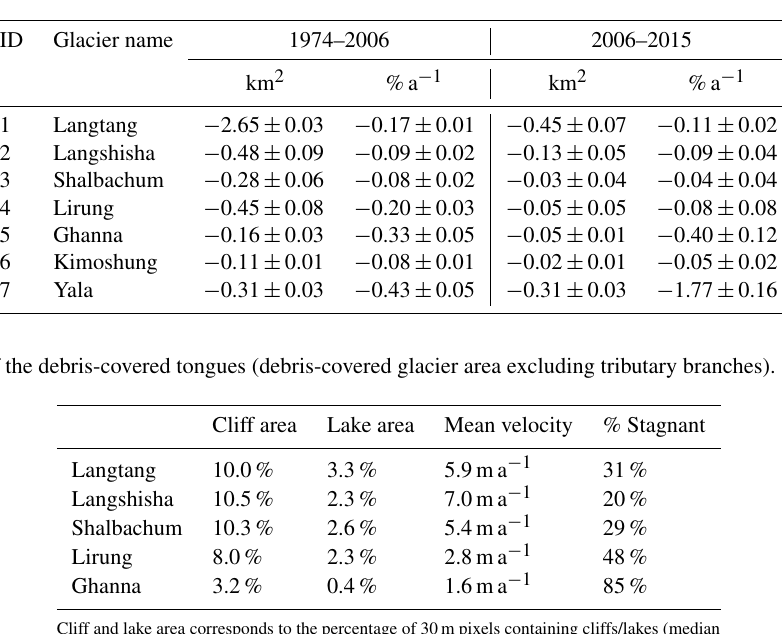
Table 6. Glacier area changes over the periods 1974–2006 and 2006–2015.